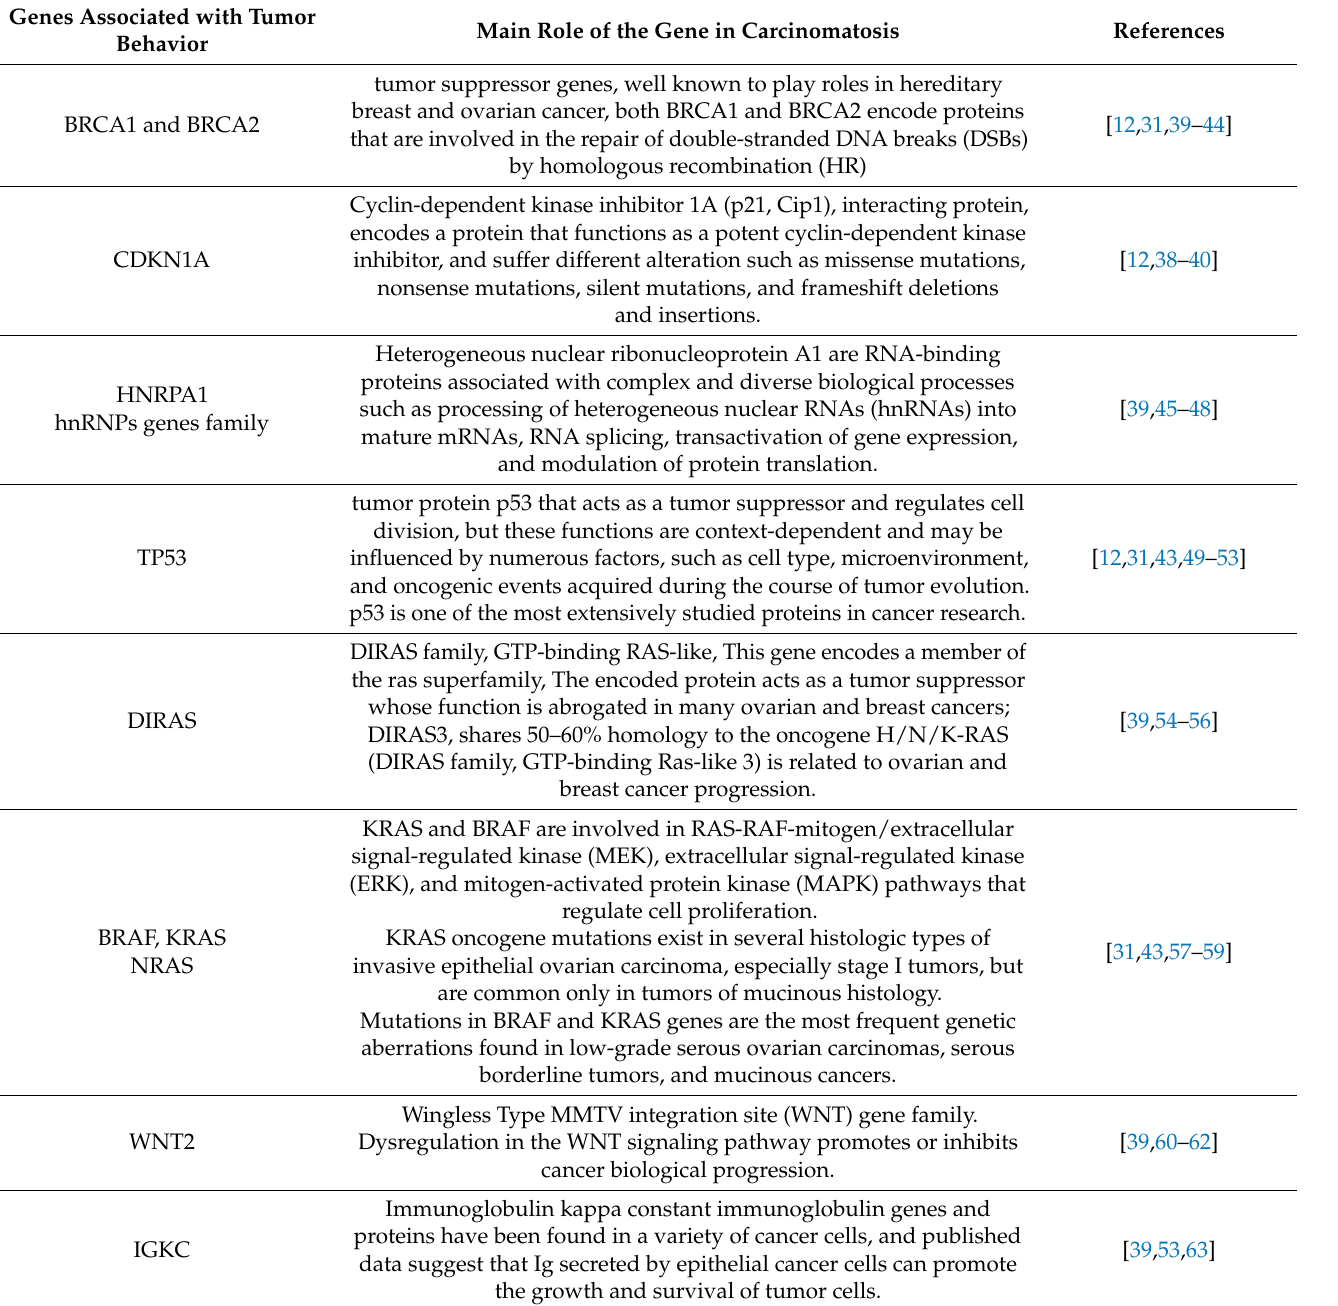
Table 2. Genes expression profiling of ovarian